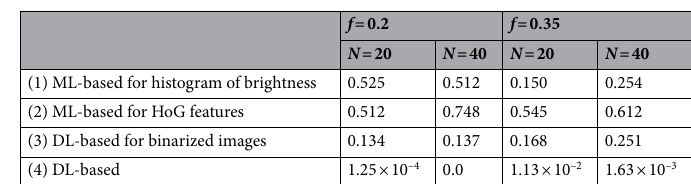
Table 2. Error rates for image classification for the 4-class problem.